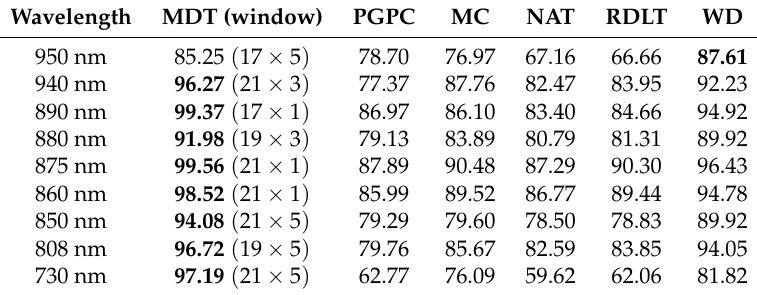
Table 2. The mean accuracy ACC of Miura match [5] obtained for different segmentation methods: MDT , PGPC , MC , NAT , RDLT , WD . For the new method MDT , the best size of operational window was given for each wavelength.